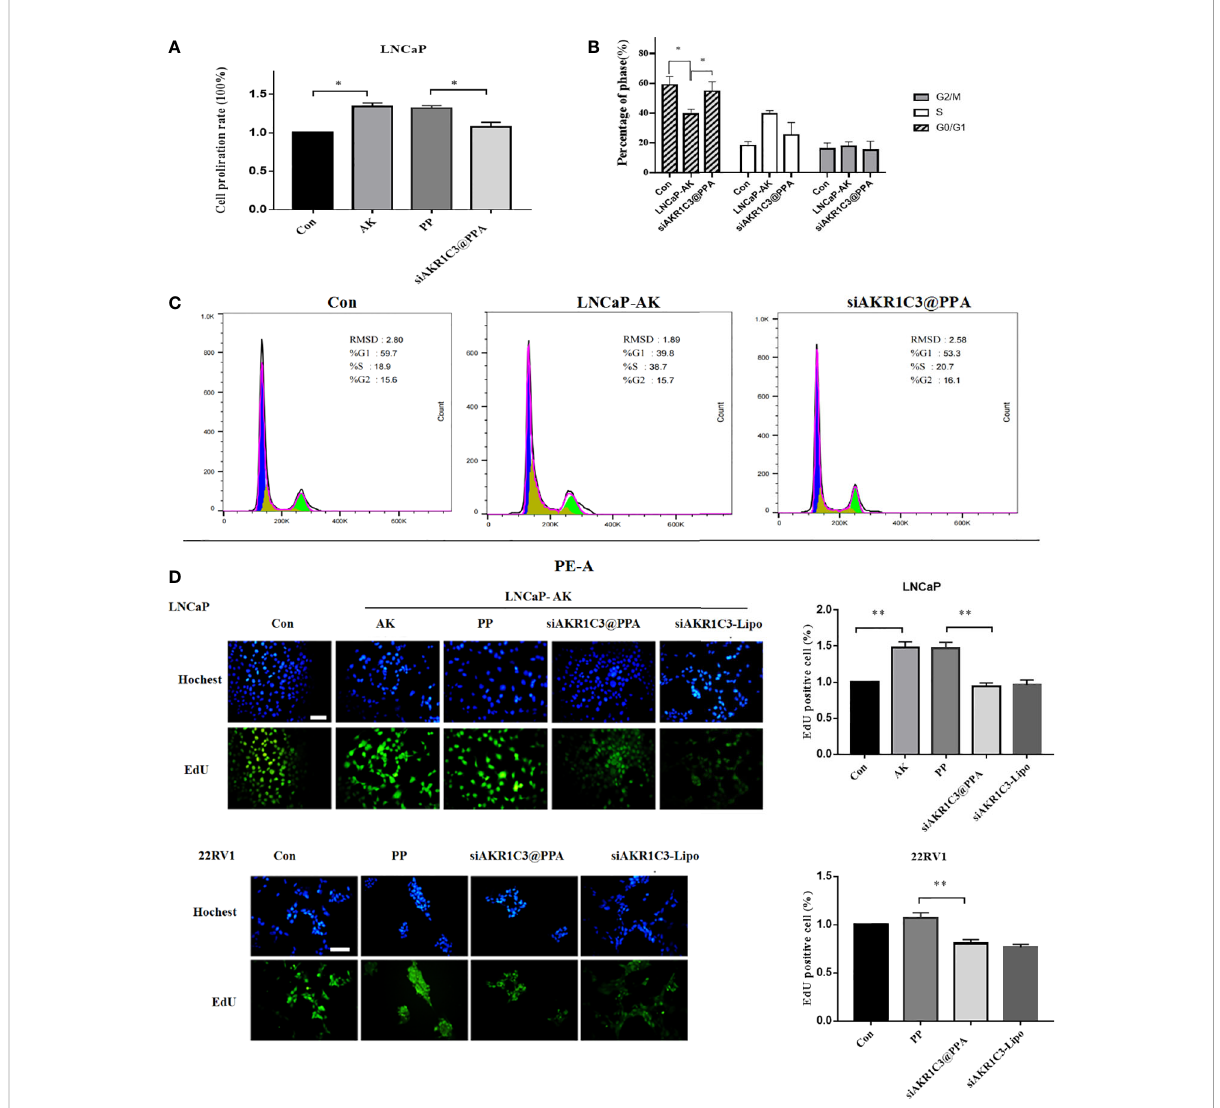
FIGURE 5 siAKR1C3@PPA inhibited the proliferation of prostate cancer cells. (A) Cell proliferation was determined by SRB in LNCaP cells for 48 h Data are presented as the mean ± SD, n=6. (B, C) Images and quanti fi ed results of the fl ow cytometric analysis,n=3. (D) Cell proliferation was determined by EdU staining (DAPI, blue; EdU-positive cells, green). Bar = 50 m m, n=3. *P < 0.05, **P <